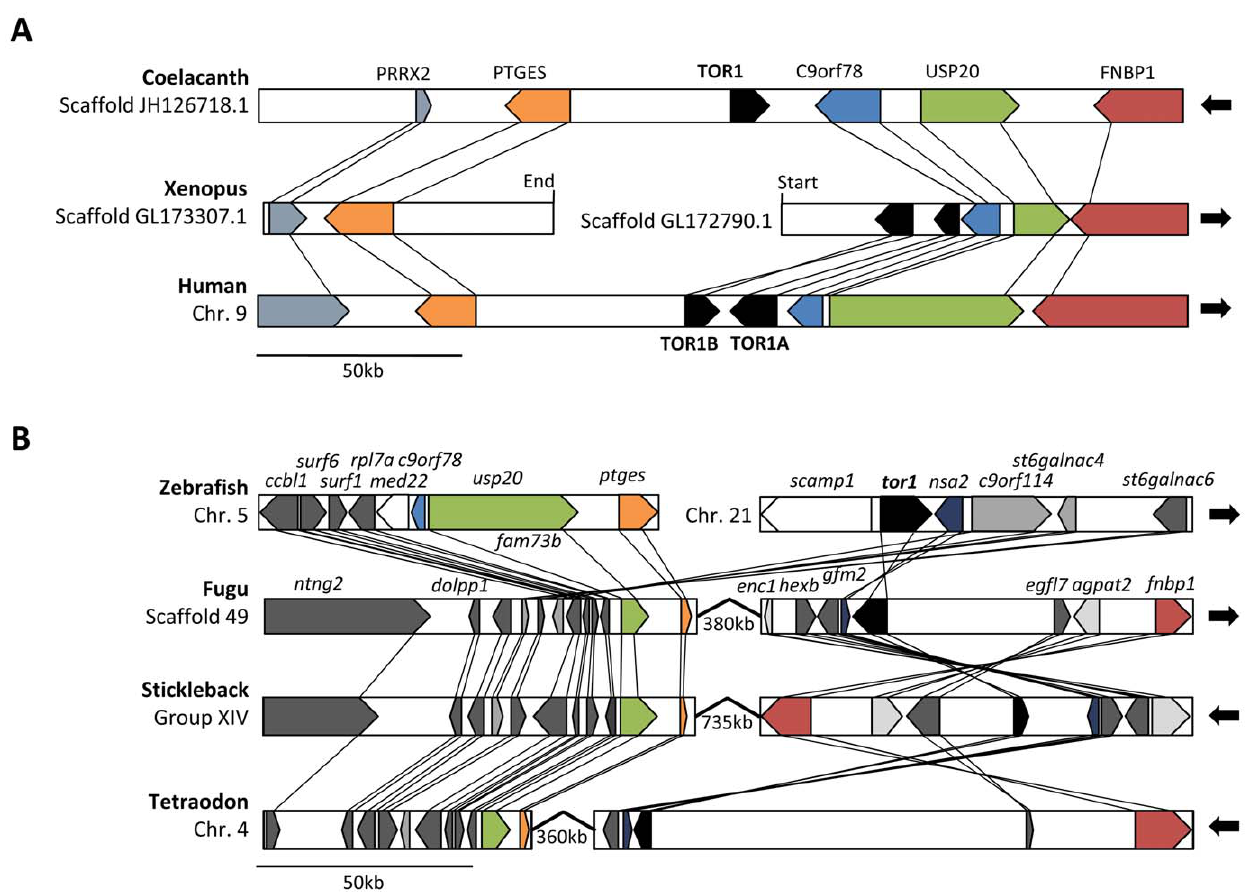
Figure 3. Syntenic relationships of tor1 , TOR1A and TOR1B. A: The diagram shows the order and orientation of genes flanking TOR1A and TOR1B in the human and xenopus genomes, and tor1 in the coelacanth genome. The map is shown to scale; large arrows show the direction of the telomere. TOR1A, TOR1B and tor1 are colored black. The flanking genes are colored green (USP20), red (FNBP1), blue (C9orf78), orange (PTGES) and lilac (PRRX2). Orthologous genes are connected by solid lines. B: The diagram shows the order and orientation of genes flanking tor1 in the zebrafish, fugu, stickleback, and tetraodon genomes. The color scheme is identical to panel A; additional flanking genes are colored as follows: dark grey - conserved chromosomal positions in all four fish species; light grey - conserved chromosomal positions in two or three fish species; white - chromosomal position not conserved.